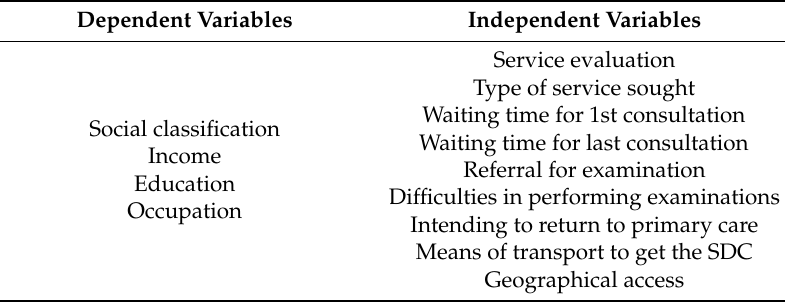
Table 1. Dependent and independent variables